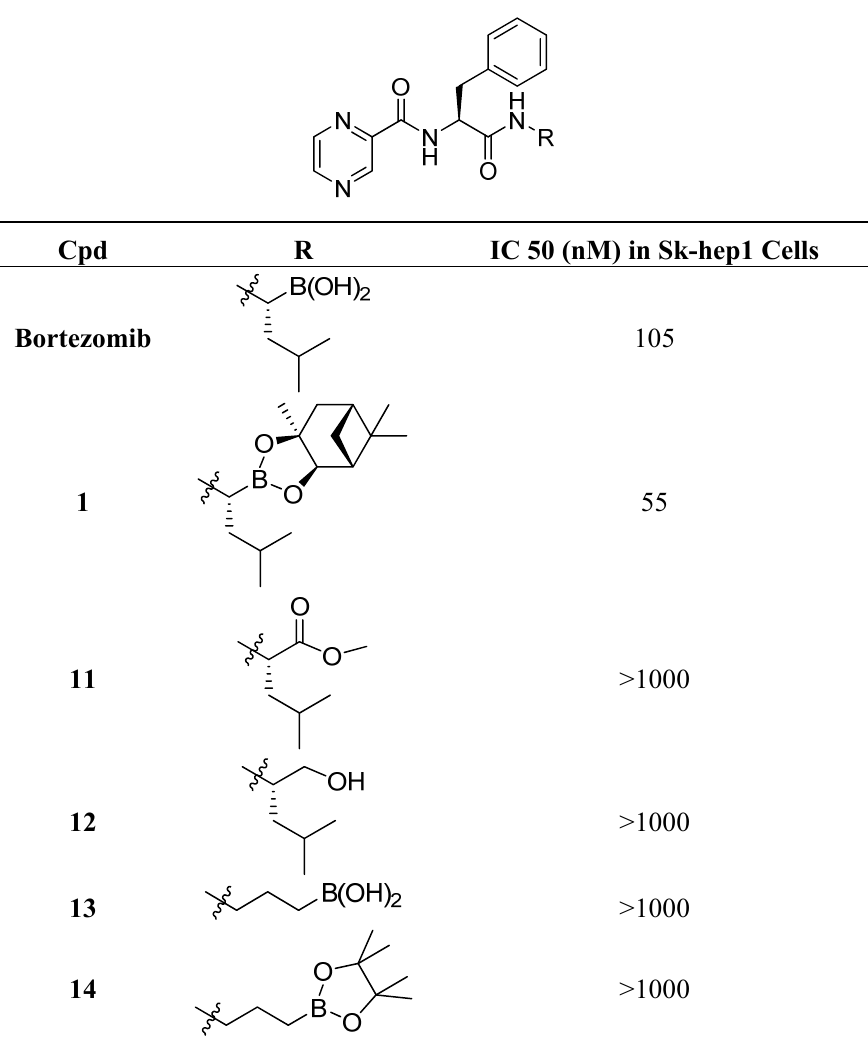
Table 1. Chemical structure of synthetized compounds and IC